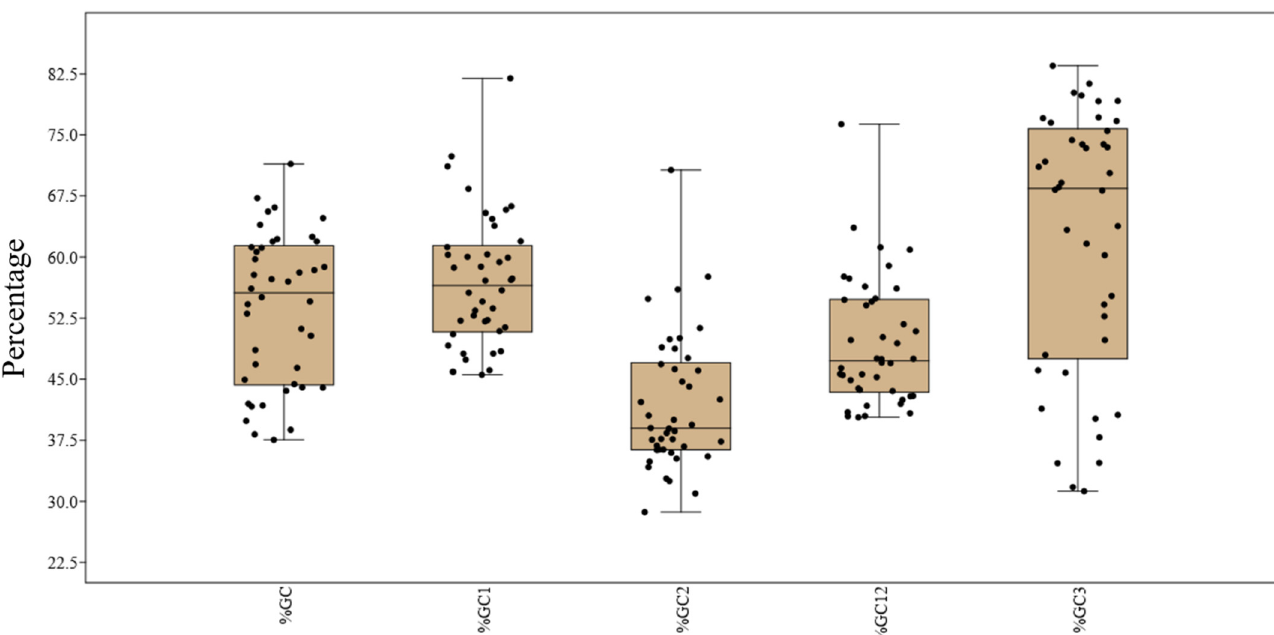
Figure 2. Jitter and boxplot showing percent occurrence of GC components at all positions.